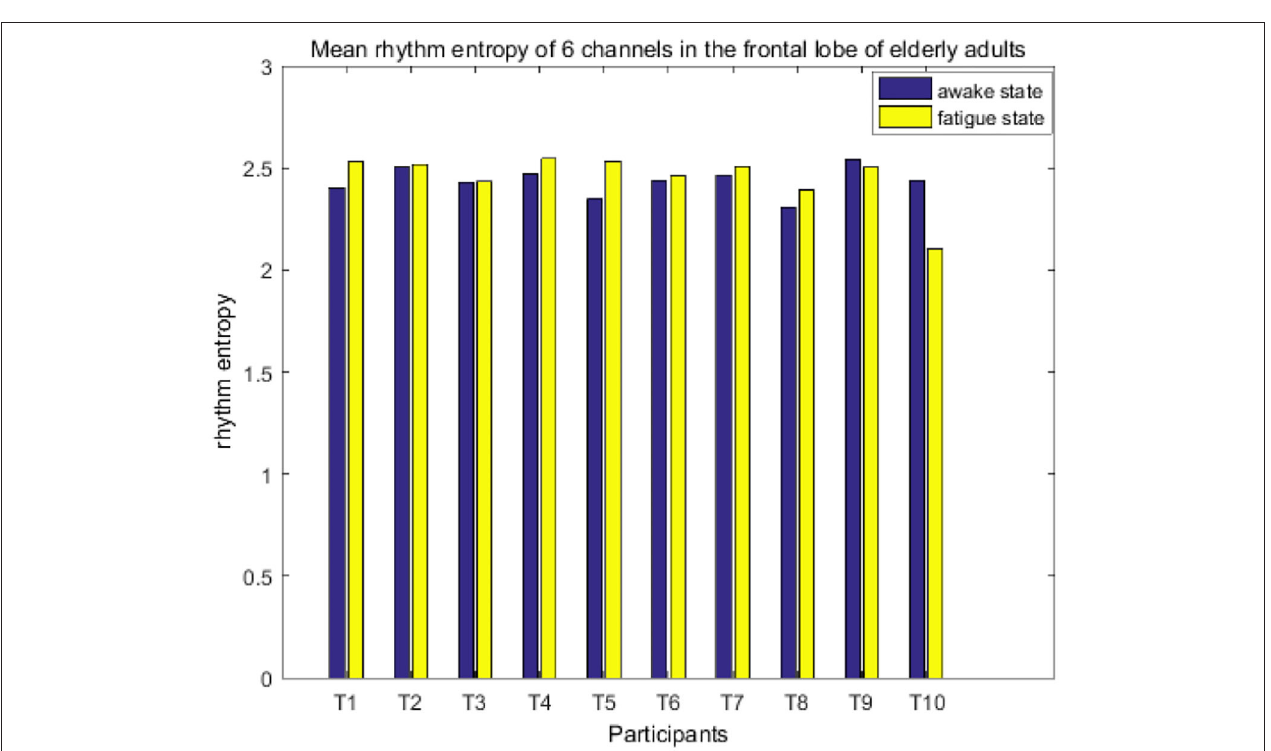
FIGURE 8 | Mean rhythm entropy of six channels on the frontal lobe of elderly adults.